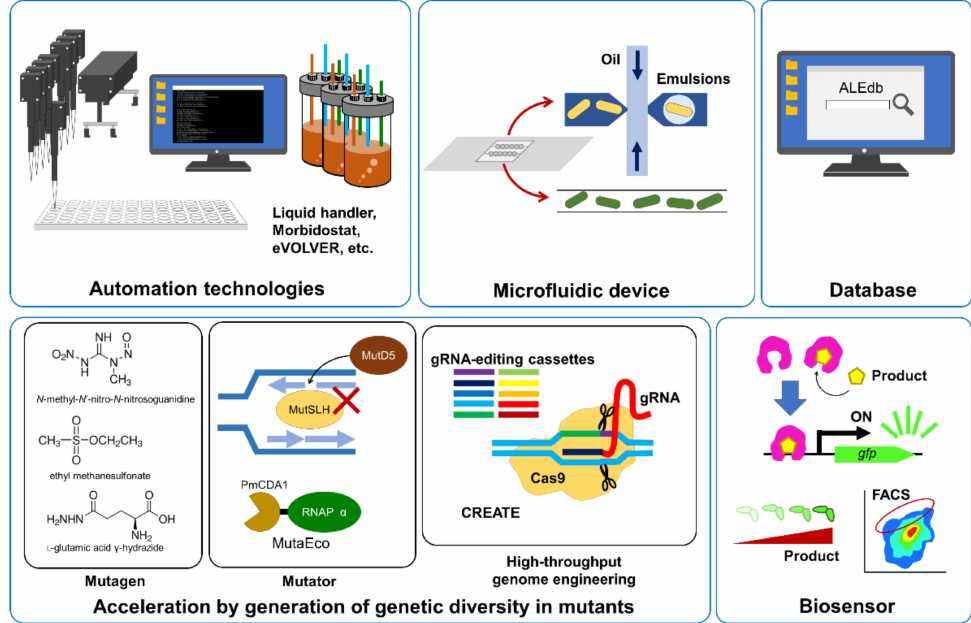
Figure 2. Useful tools for ALE. Automation technologies, including liquid handlers and automated culture control systems for continuous culture (morbidostat and eVOLVER) are powerful tools for ALE to deal with the limitations of manual approaches. To accelerate ALE, mutation rates can be increased by the addition of mutagens, exposure to UV, and manipulation of DNA replication or repair systems. High-throughput genome engineering, e.g., CREATE technology, can generate genetic diversity in mutants for ALE. For ALE to increase product formation, biosensors and FACS are useful to detect intracellular levels of product and sort cells showing higher titer. Microfluidic devices are highly manipulable, and they can be applied for the generation of precise chemical gradients in consecutive microcompartments. Additionally, emulsions such as “water-in-oil” microdroplets can compartmentalize cells inside the droplets. Thus, it can be used for the selection of beneficial cells with slow growth rates. Databases of mutations identified by many ALE studies are valuable for analysis and intuitive